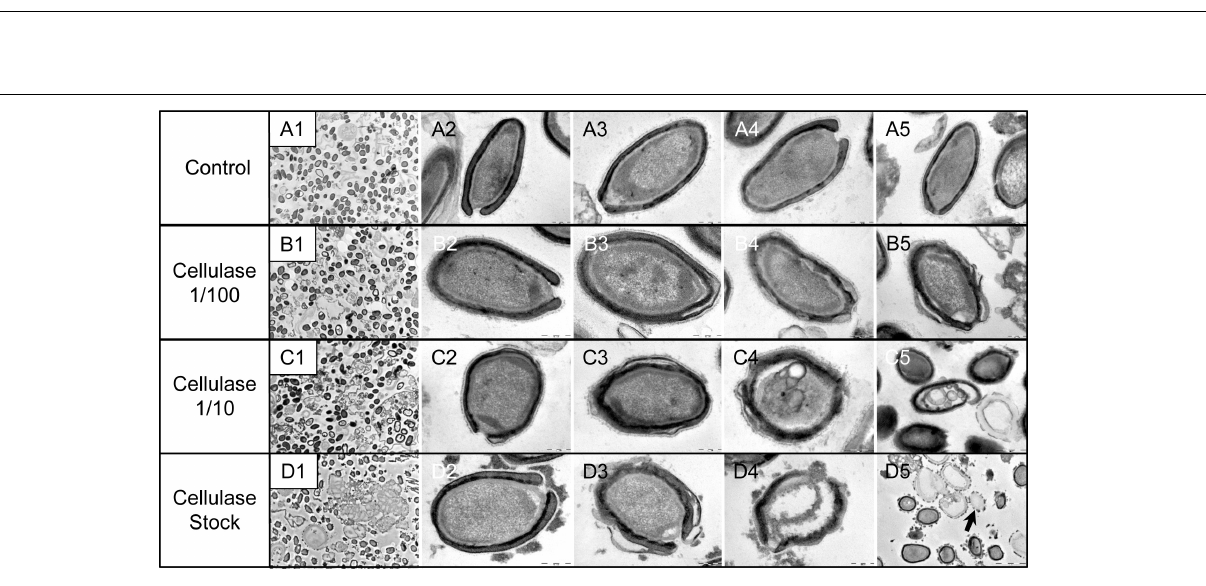
FIGURE 9 | Transmission electron microscopy of cellulase-treated P. massiliensis particles. (A1–A5) Control condition with untreated P. massiliensis particles. (B1–B5) P. massiliensis particles treated with cellulase solution diluted at 1:100, (B3–B5) particles showed a defect of the envelope. (C1–C5) P. massiliensis particles treated with cellulase solution diluted at 1:10, (C3–C5) particles exhibited detachments of the different layers of the envelope. (D1–D5) P. massiliensis particles treated with cellulase solution stock. (D3–D5) Particles imaged in different stages of digestion from least to the most digested. (D5) “Ghost-like” particles presenting totally empty internal spaces and only a thin surrounding tegument (black